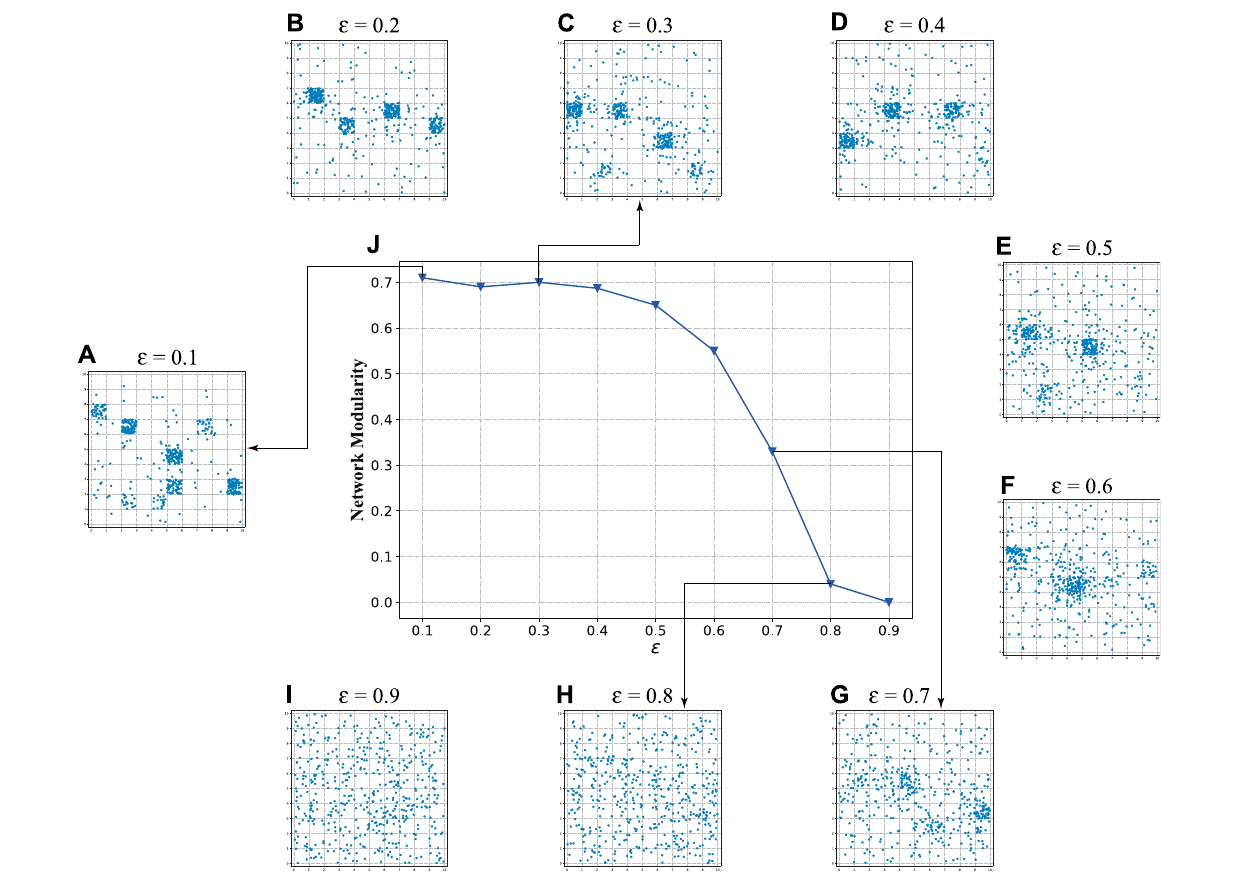
FIGURE 8 | Impact of ϵ on the network community evolution process. (A – I) are the representations of ϵ in (0.1 – 0.9) in the low dimensional vector space, respectively, and (J) is the variation curve of network modularity with increasing ϵ .